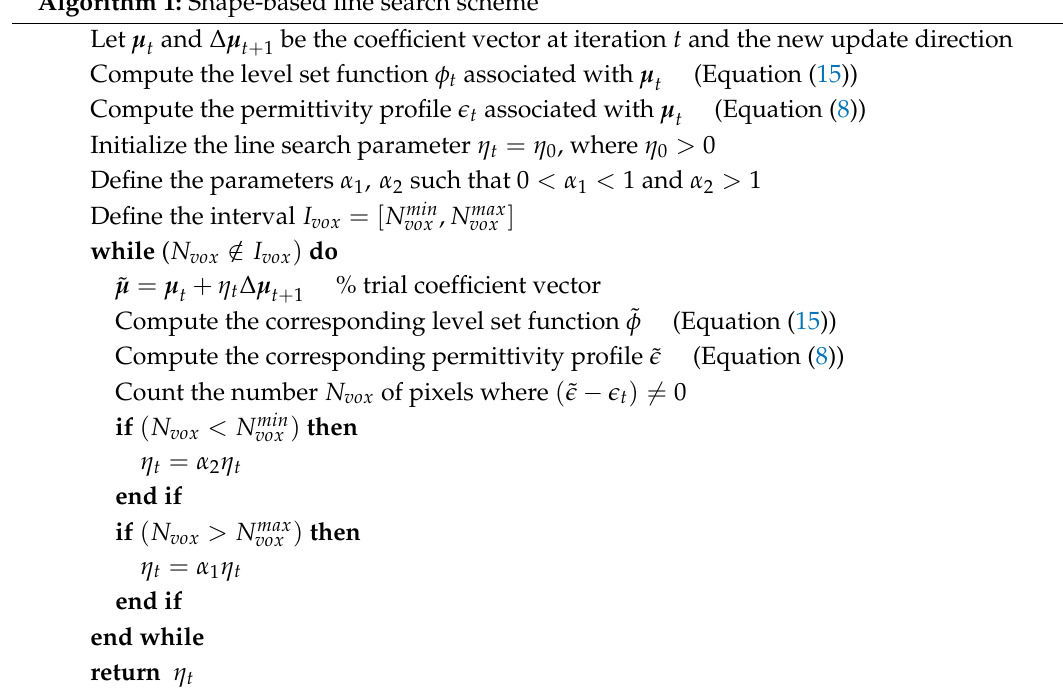
Algorithm 1: Shape-based line search